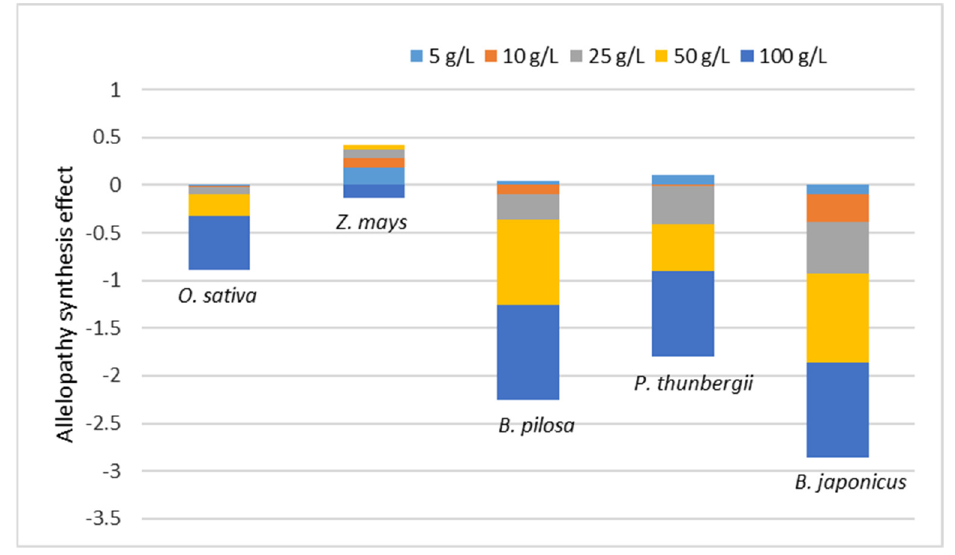
Figure 3. Allelopathy synthesis effect of aqueous extracts from fleagrass on five target plants.